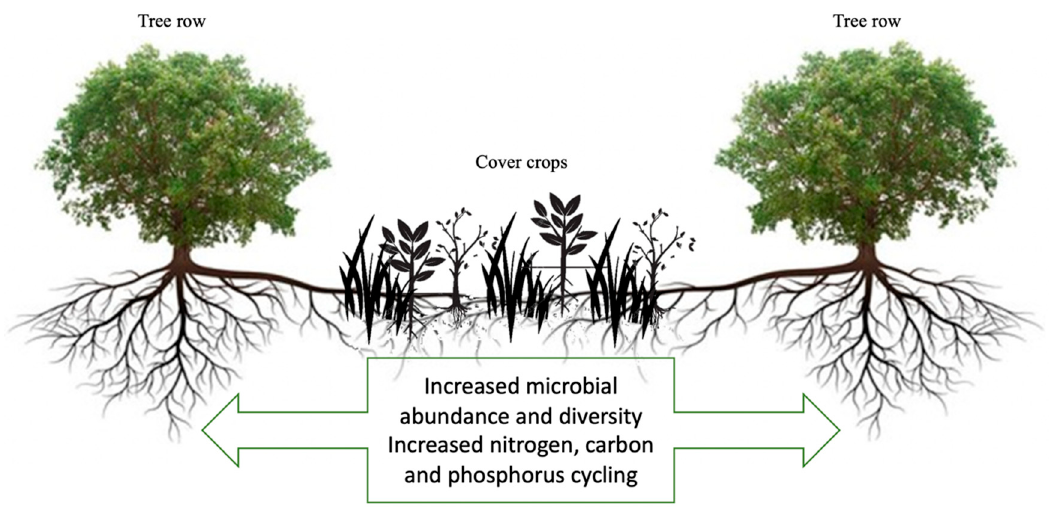
Figure 3. Illustration of the impacts of cover crops on tree crops.